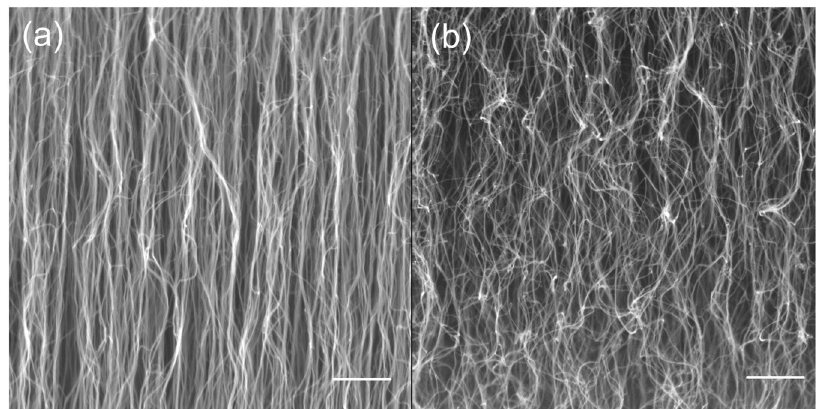
Fig. 1 SEM images of carbon nanotube forests. The structural morphology of a CNT forests may exhibit relatively aligned CNTs ( a ) or wavy and entangled CNTs ( b ) depending on synthesis conditions. Scale bars represent 500